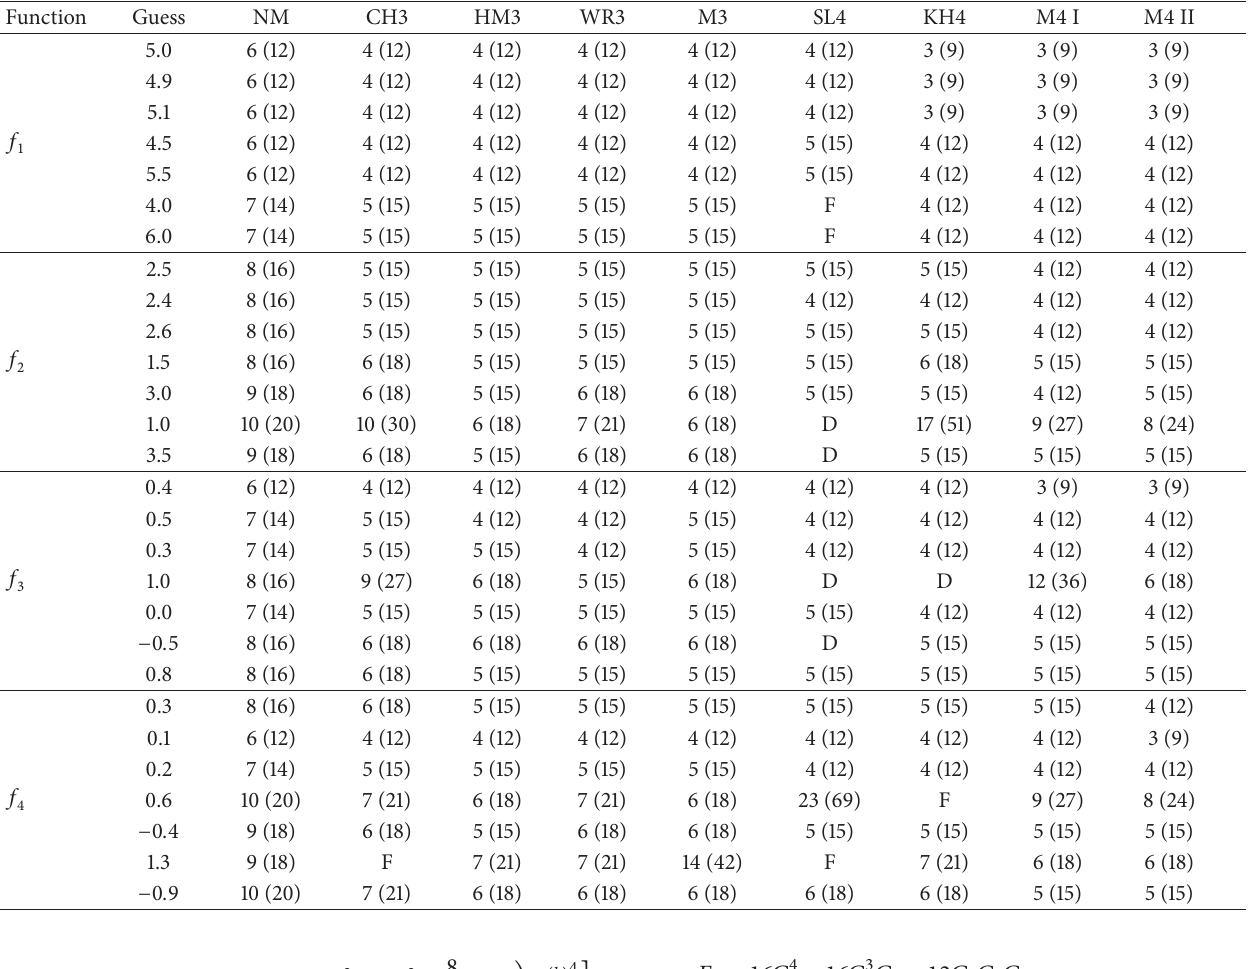
Table 4: Comparison of the number of iterations and function